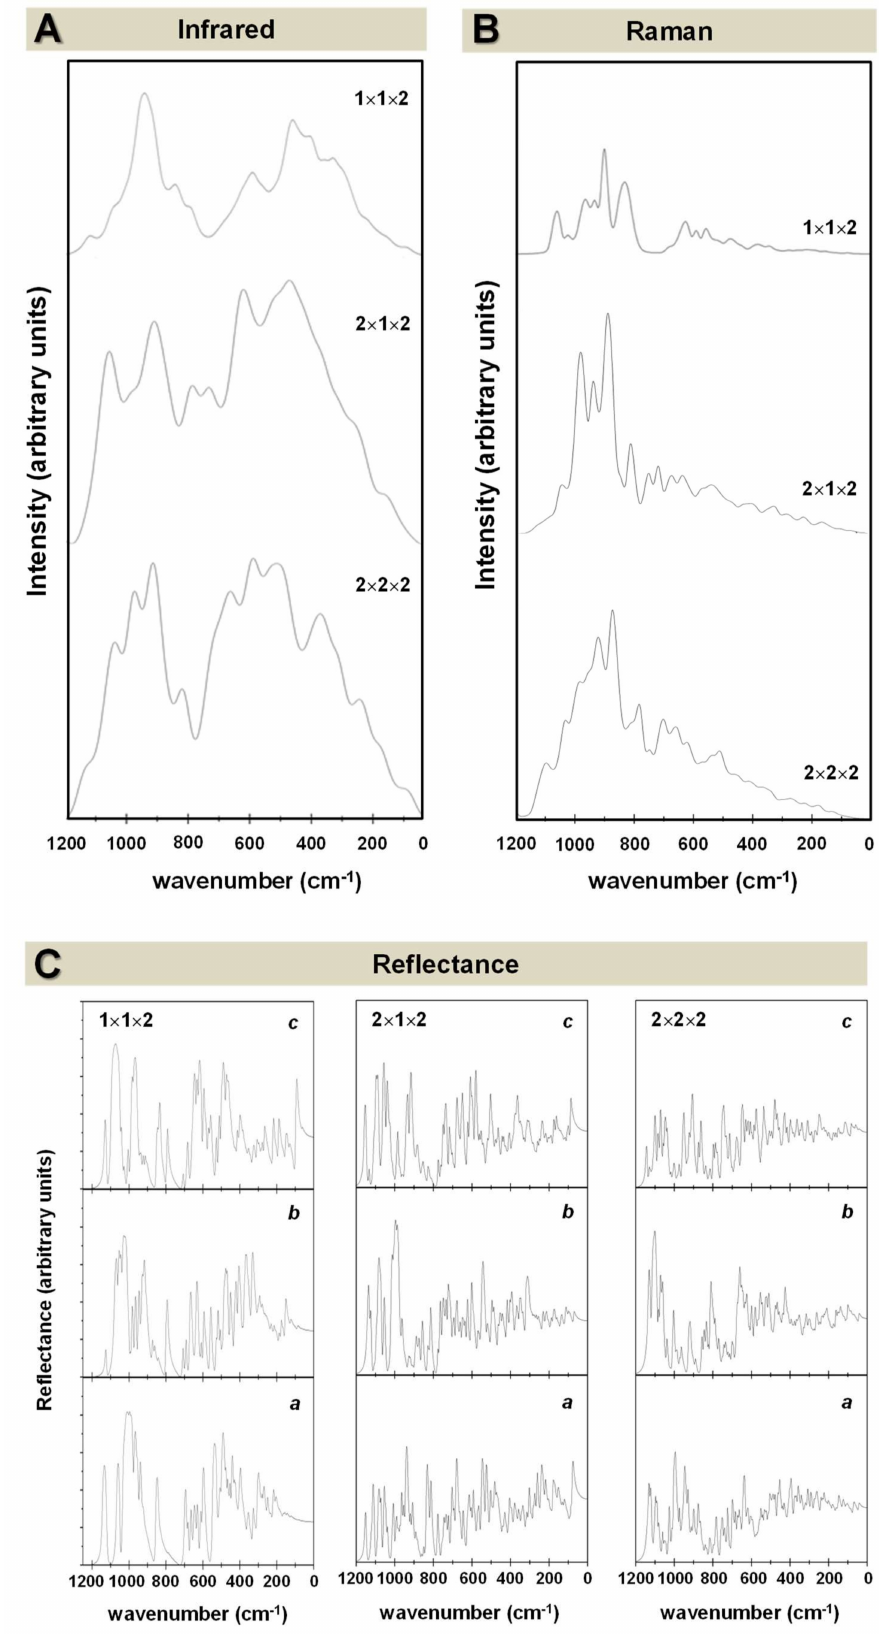
Figure 9. B3LYP-simulated infrared ( A ), Raman ( B ), and reflectance spectra along the a , b , and c directions ( C ) of the Mg 2 SiO 4 bulk structures adopting the 1 × 1 × 2, 2 × 1 × 2, and 2 × 2 × 2 super-cell